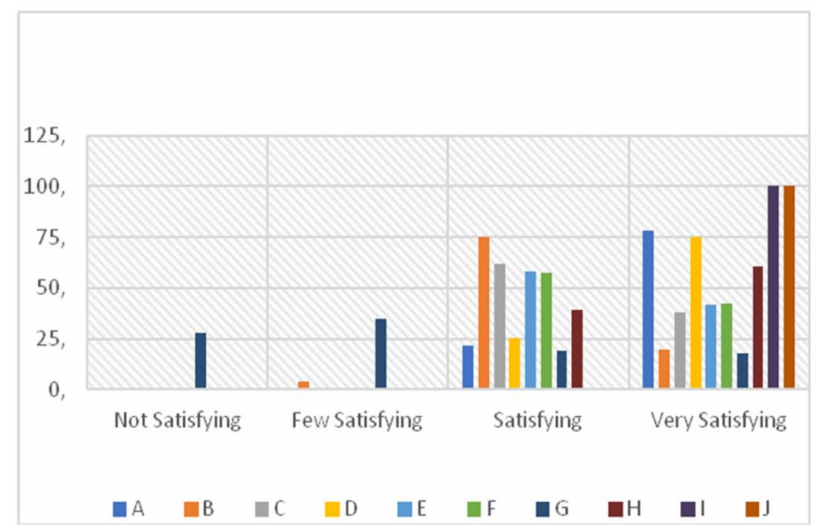
Figure 1. Graphical representation of the investigated feedback. The introduction of the virtual dissection table (DT) was overall welcomed by the nursing students.